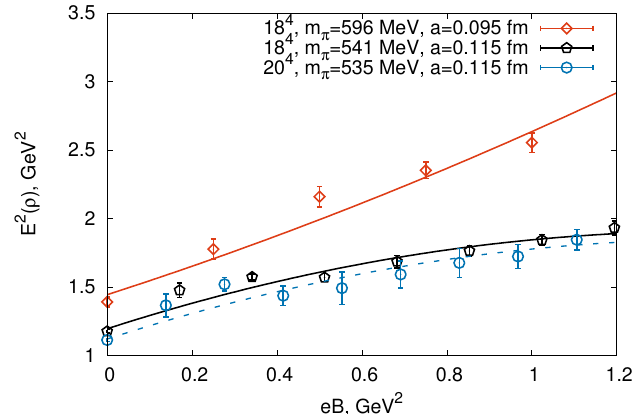
Figure 13. The energy squared of the ground state of the (cid:26) (cid:6) meson with the spin projection s z = 0 versus the (cid:12)eld value for the lattice volumes 18 4 and 20 4 , the lattice spacings 0 : 095 fm, 0 : 115 fm and various pion masses m (cid:25) with the corresponding (cid:12)ts